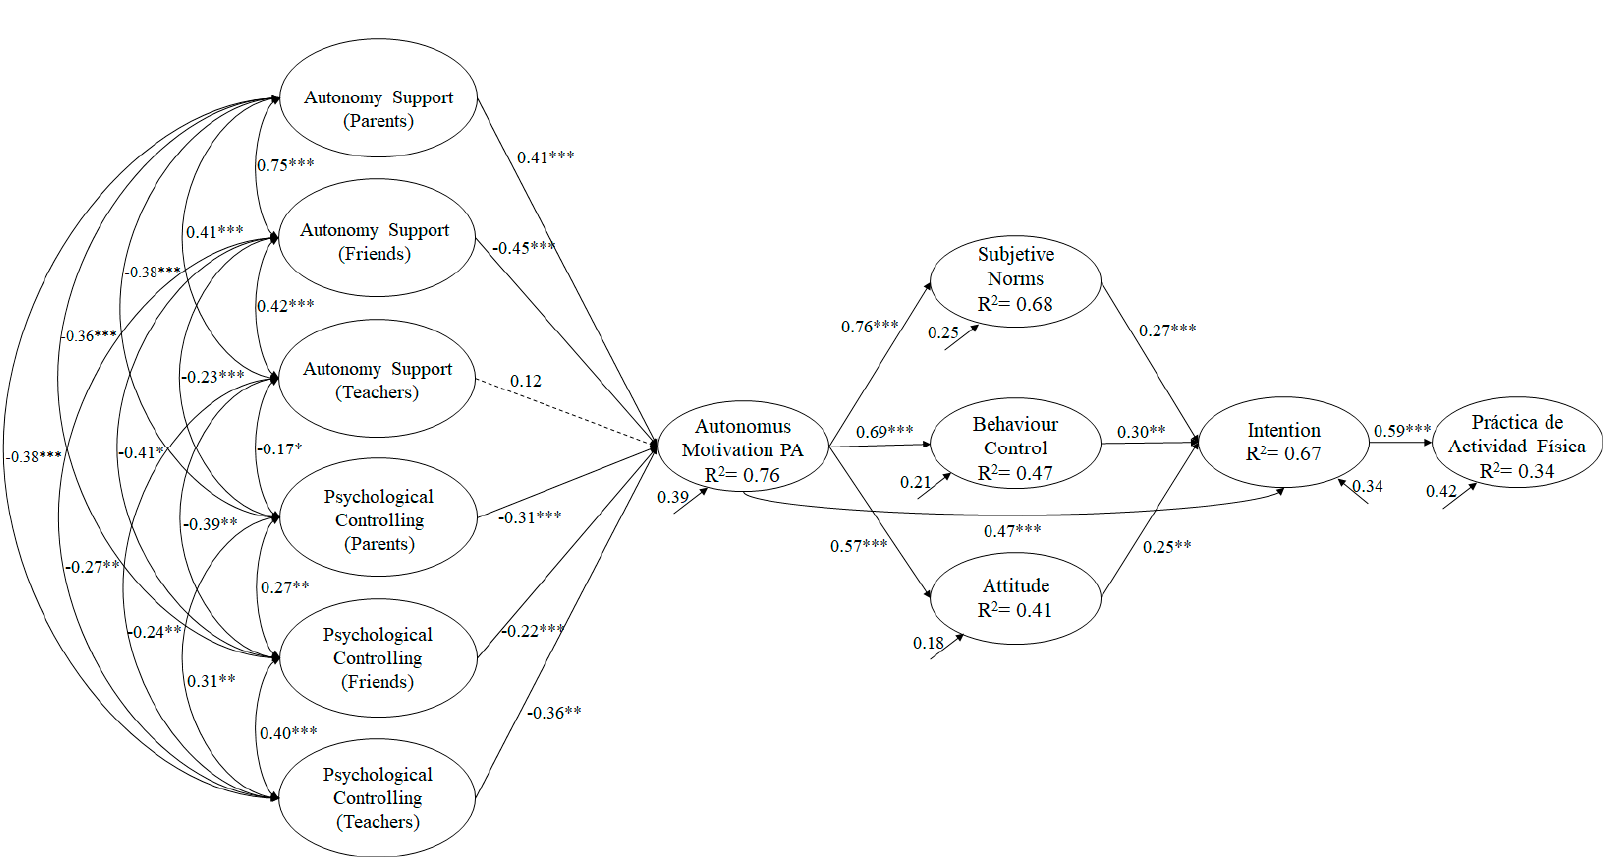
Figure 4. A hypothesized model showing the importance of social context on motivation and planned behaviour.